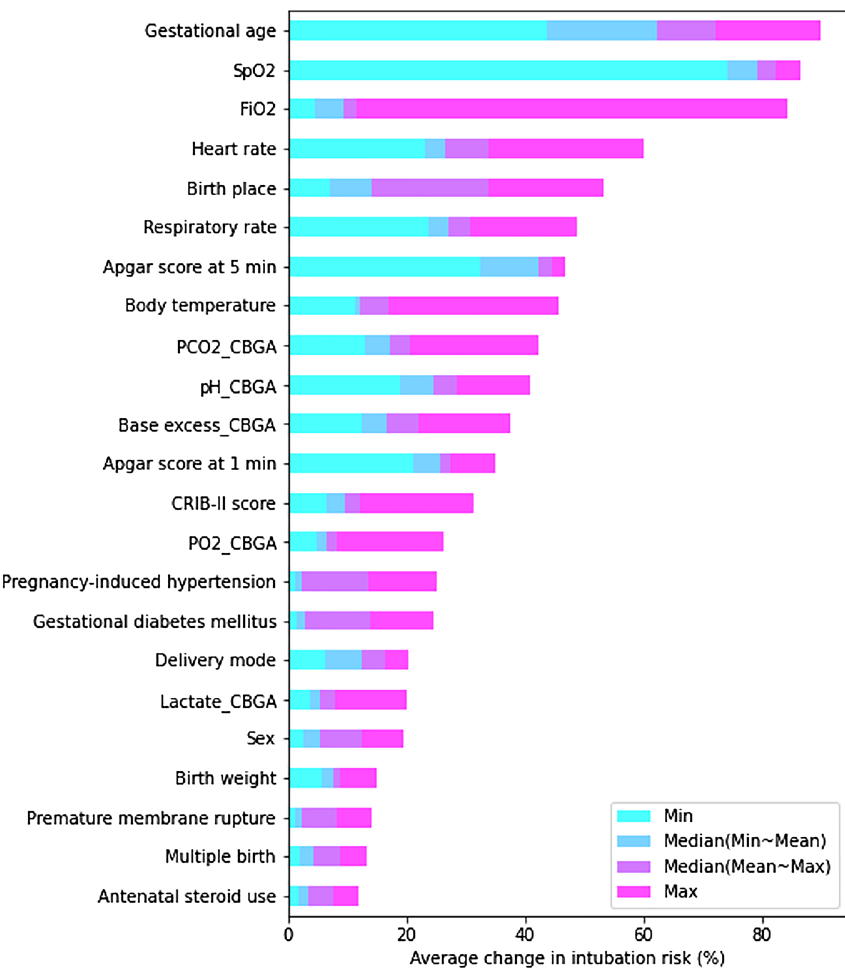
Figure 7. Sensitivity analysis for the intubation risk prediction of the multimodal deep neural network model. This chart showed the average changes in the intubation risk (%) due to varying each attribute individually while holding all others at their